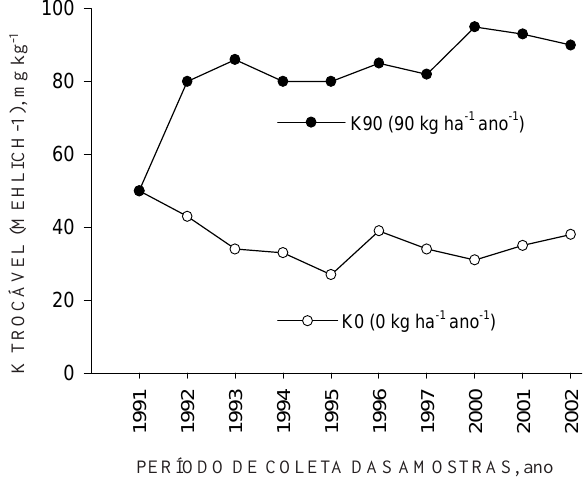
Figura 1. Teor de potássio trocável, extraído por Mehlich-1, em amostras de solo (0–10 cm) que não receberam (K0) e que receberam potássio (K90) via fertilização durante 11 anos.